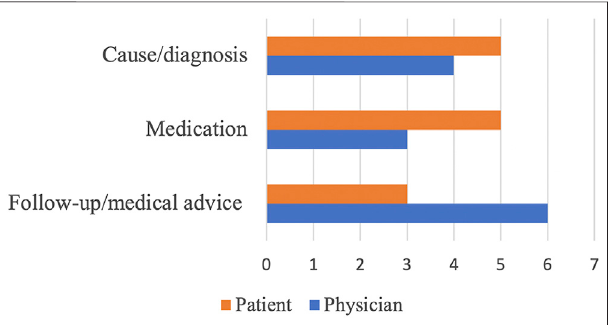
FIGURE 2 | Patients ’ and physicians ’ responses of most important information items, divided in